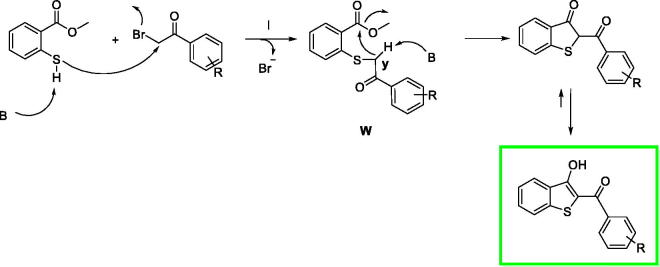
Proposed mechanism of reaction.